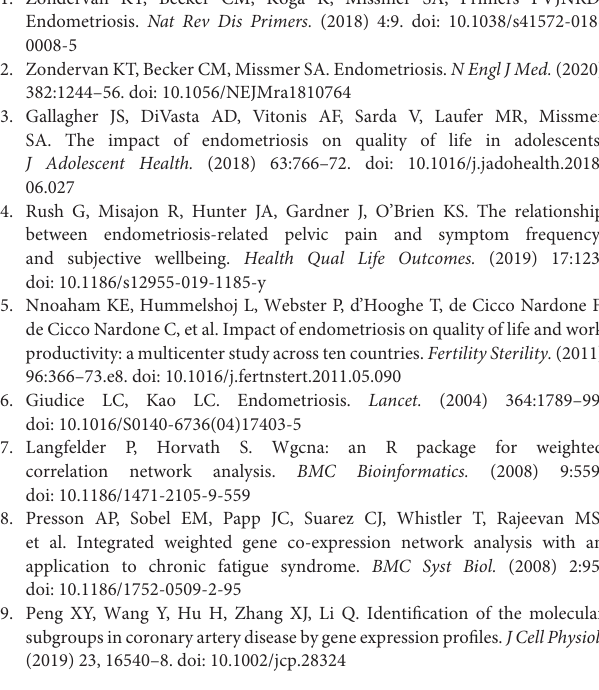
Supplementary Table 8 | The hub genes. Supplementary Table 9 | The GO enrichment analysis results of hub genes. Supplementary Table 10 | The KEGG enrichment analysis results of hub genes. Supplementary Table 11 | Intersection of KEGG enrichment analysis results of hub genes and gene set 1. Supplementary Table 12 | MiRNA related to infertility. Supplementary Table 13 | Intersection of predicted miRNA target gene and gene set 1. Supplementary Table 14 | MiRNA-mRNA